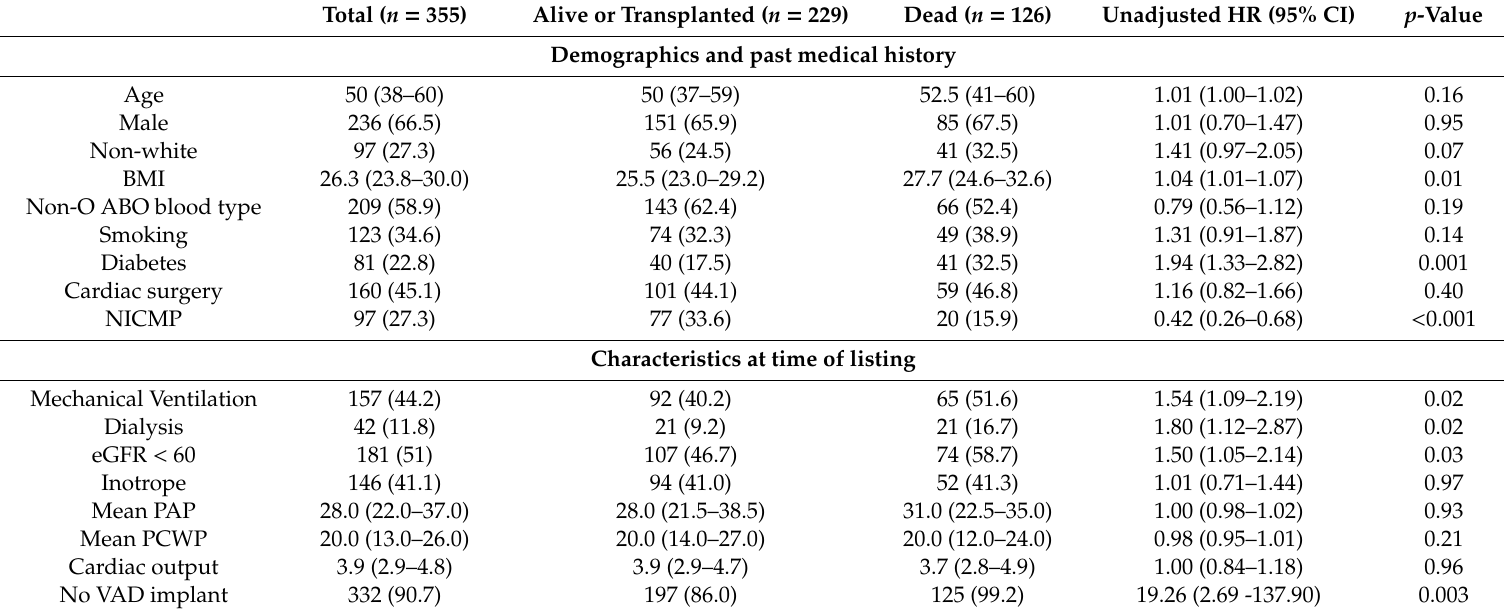
Table 2. Baseline characteristics and univariate predictors of waitlist mortality (death on the